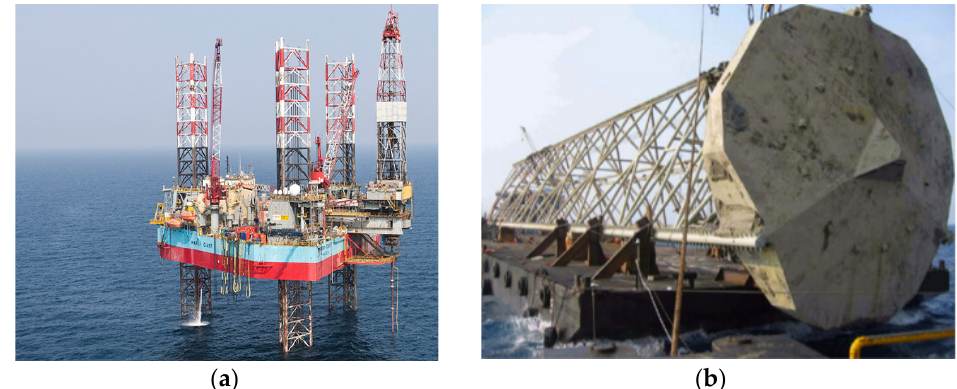
Figure 1. Jack-up drilling rig: ( a ) jack-up drilling rigs (https://ramboll.com/projects, accessed on 1 January 2023); ( b ) spudcan [1]. Table 1. Main characteristics of different jack-up rigs [2].